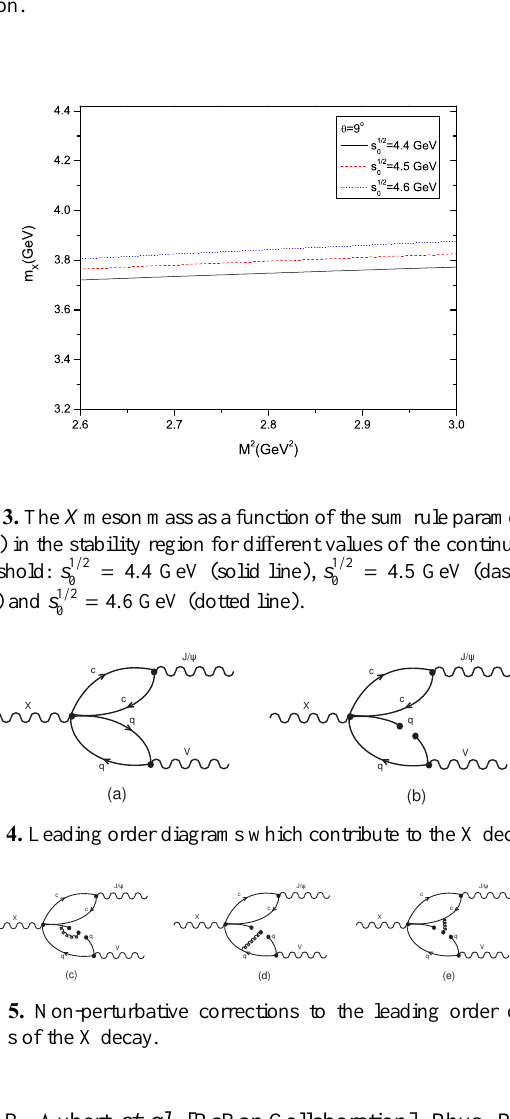
Fig. 2. The dashed line shows the relative pole contribution (the pole contribution divided by the total, pole plus continuum, con- tribution) and the solid line shows the relative continuum contri- bution.